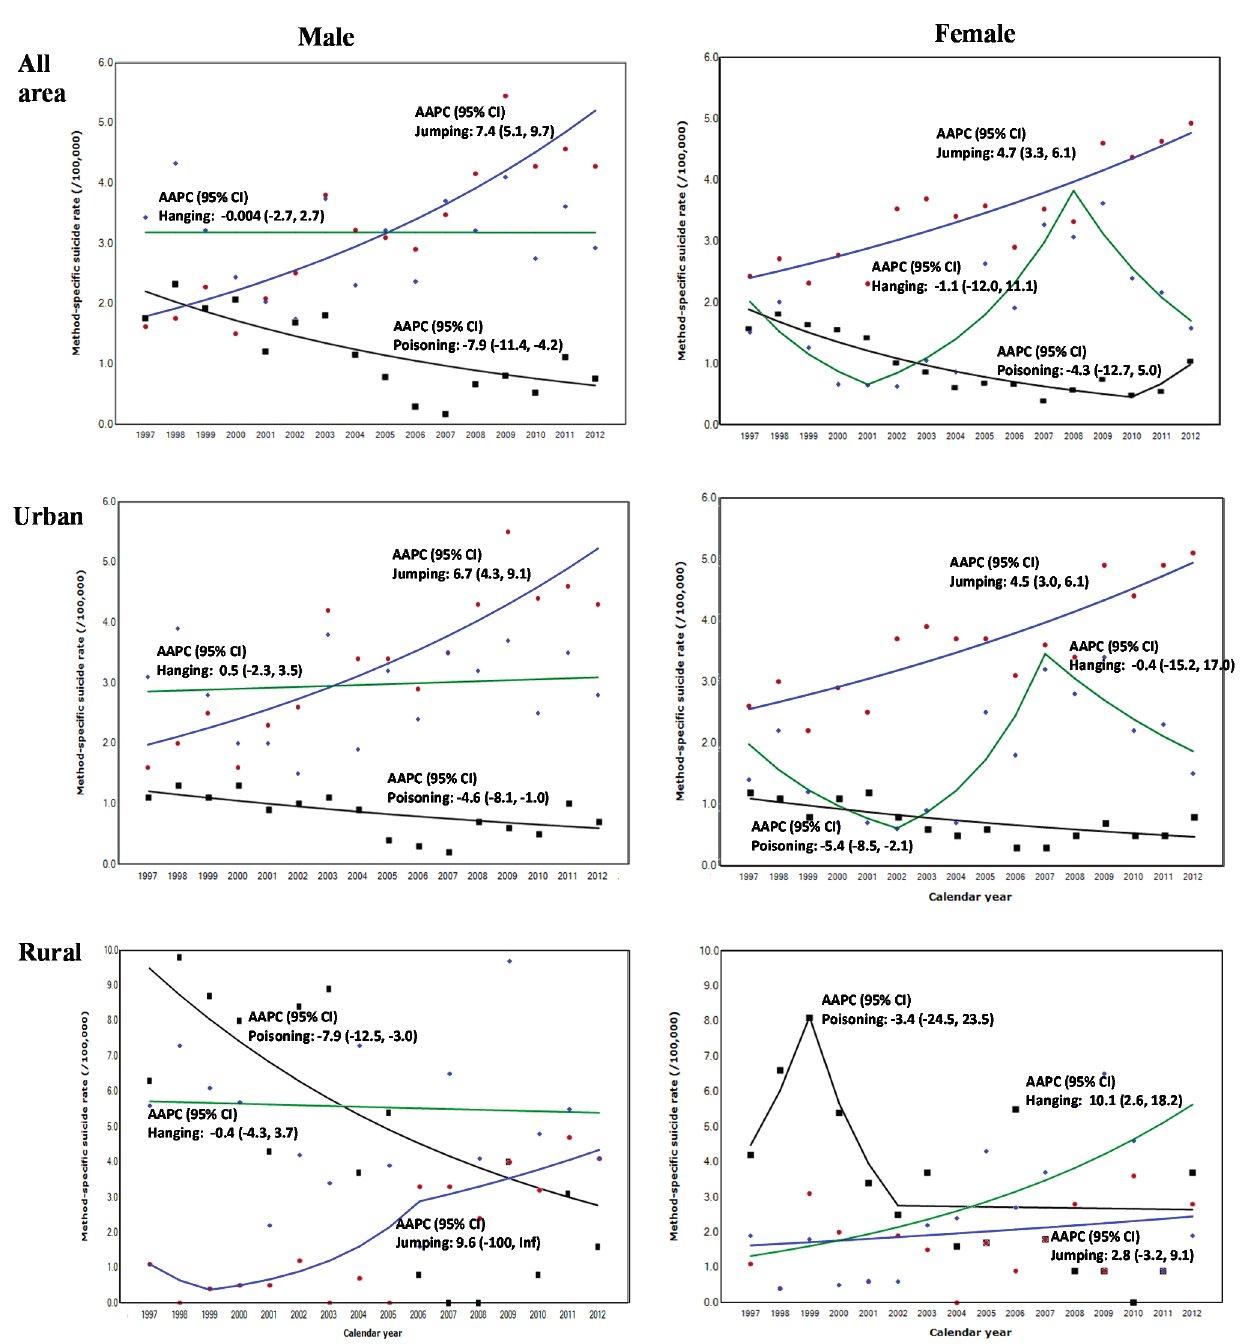
Figure 3. Method-specific suicide rate and annual average percent change (AAPC) according to urbanity among adolescents, 15–19 years of age by gender in Korea, 1997–2012; Model selection using Monte Carlo Permutation method